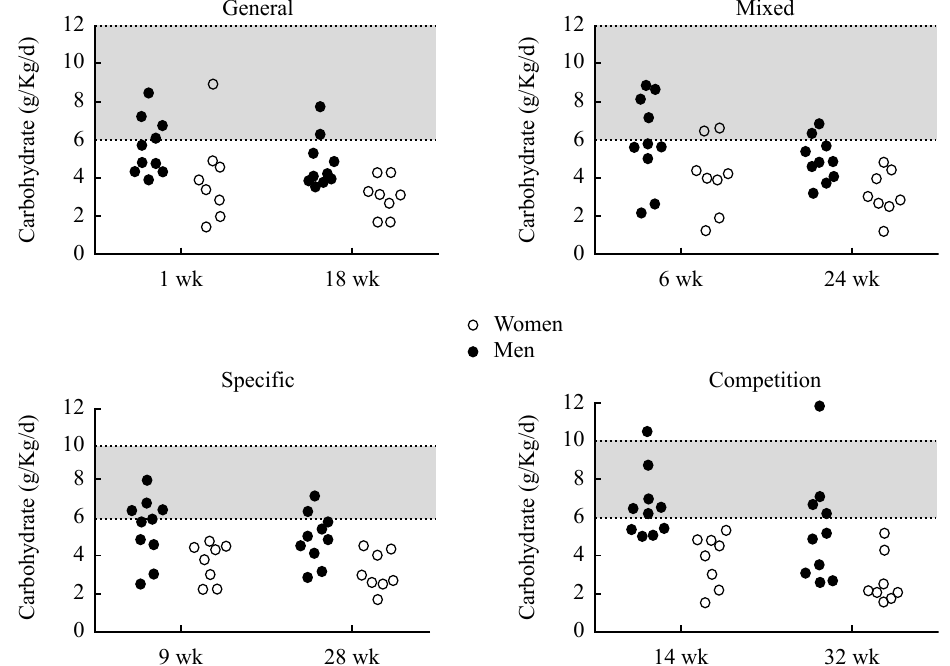
Figure 3. Individual carbohydrate intake and recommendation (grey band) for each training phase (in two macrocycles) by male (n=10) and female (n=8) swimmers.